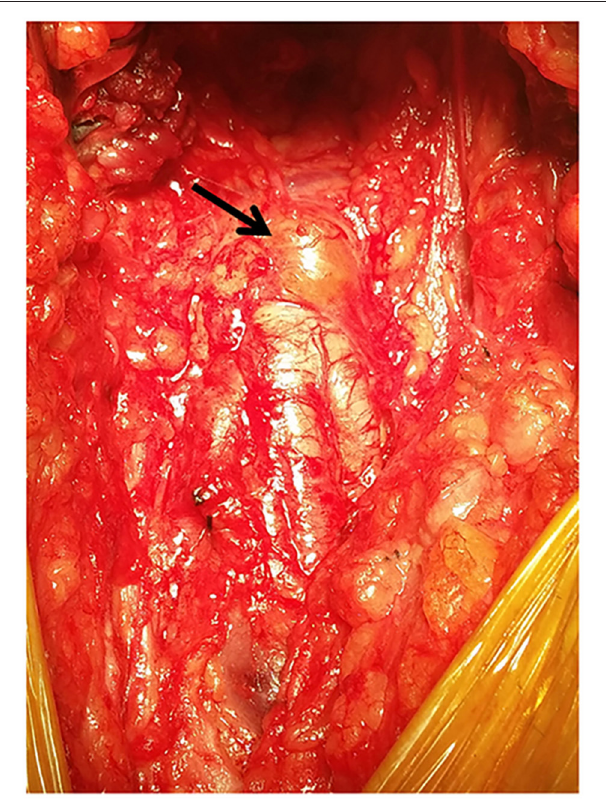
FIGURE 2 | Intraoperative photograph showing the adventitial cyst on the anterior wall of the common femoral artery (black arrow).